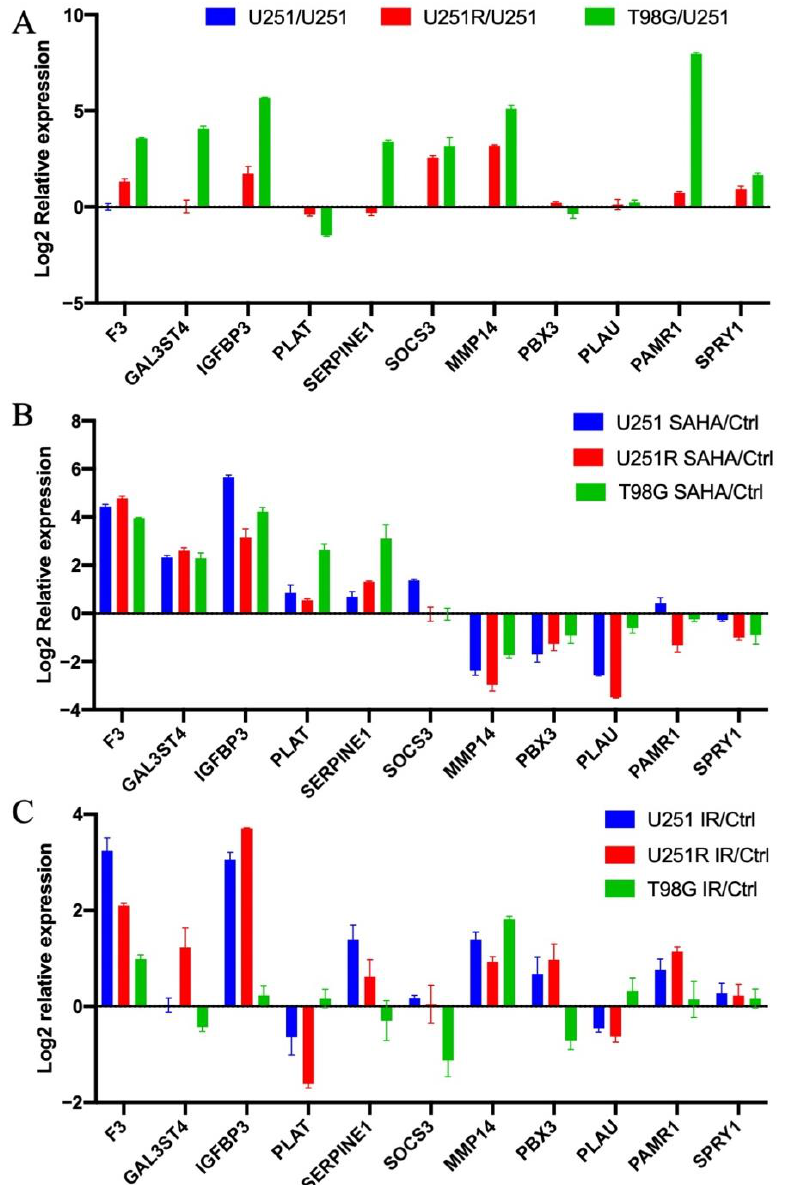
Figure 6. The RT-qPCR assay of eleven candidate genes. ( A ) RNA expression levels of 11 candidate genes in U251, U251R, and T98G cells. ( B ) RNA expression levels of 11 candidate genes in U251, U251R, and T98G cells after SAHA treatment. ( C ) The RNA expression levels of 11 candidate genes in U251, U251R, and T98G cells after irradiation for 48 h. The y-axis represents the log2 fold change of RNA expression level. Abbreviations: RT-qPCR, reverse transcription-quantitative polymerase chain reaction; SAHA, suberoylanilide hydroxamic acid; IR, irradiated; Ctrl, control. According to the reverse transcription-quantitative polymerase chain reaction (RT- qPCR) data, MMP14 RNA expression was considerably higher in radioresistant cell lines level of MMP14 was compatible with the bioinformatics analysis of “Radio_genes”.